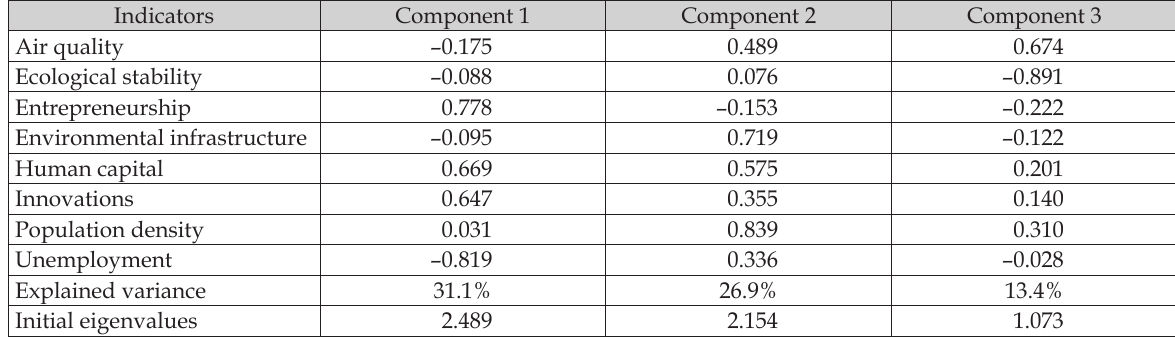
Table 2. PCA – Rotated component